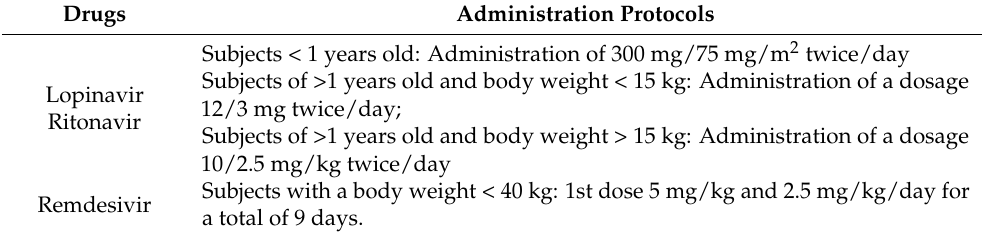
Table 5. COVID-19 antiviral dosing.